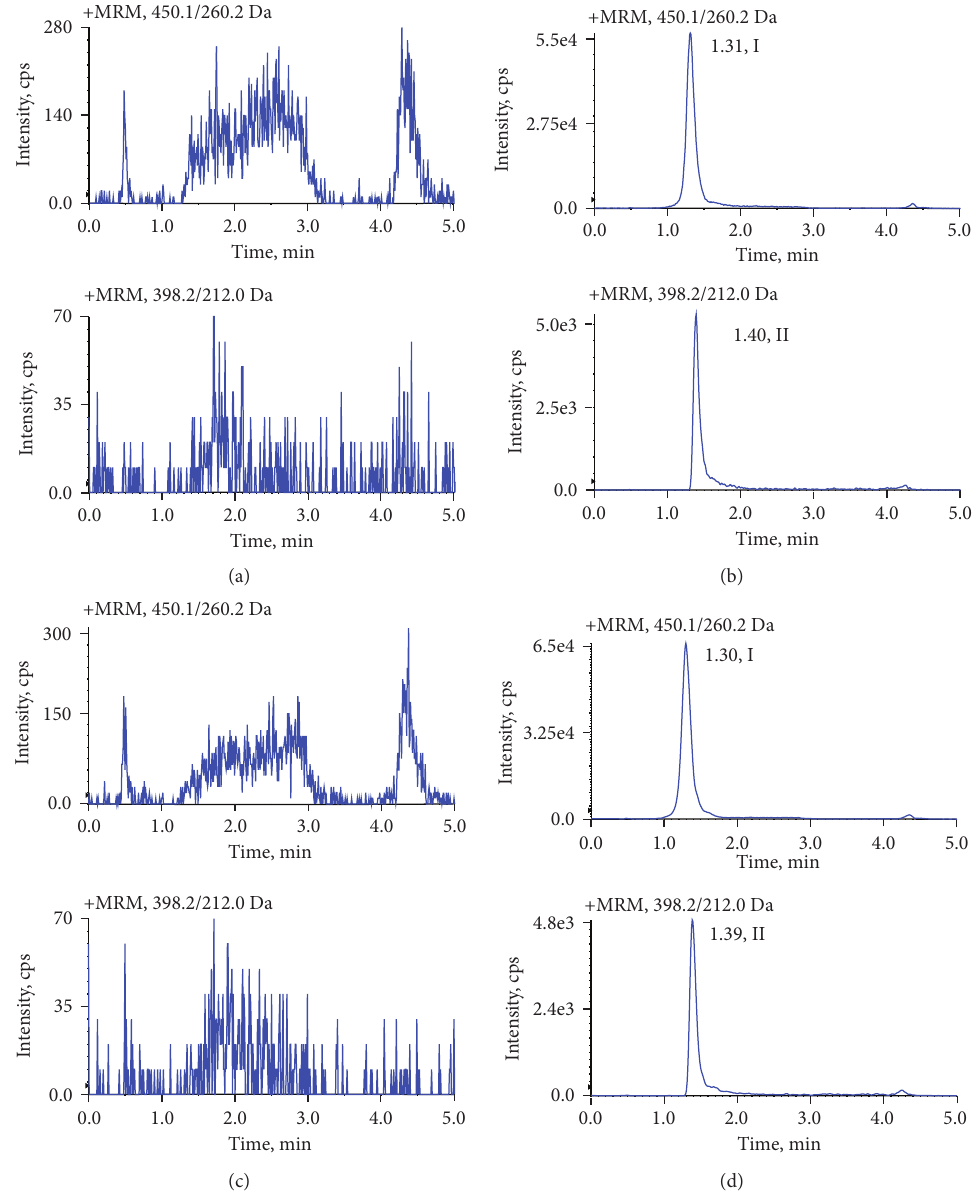
Figure 4: Typical MRM chromatograms of crizotinib (I) and apatinib (II, IS). (a) Blank liver homogenate sample; (b) liver tissue sample obtained from a mouse at 8 h after intragastric administration of 500mg/kg crizotinib; (c) blank small intestine homogenate sample; and (d) small intestine tissue sample obtained from a mouse at 8h after intragastric administration of 500 mg/kg